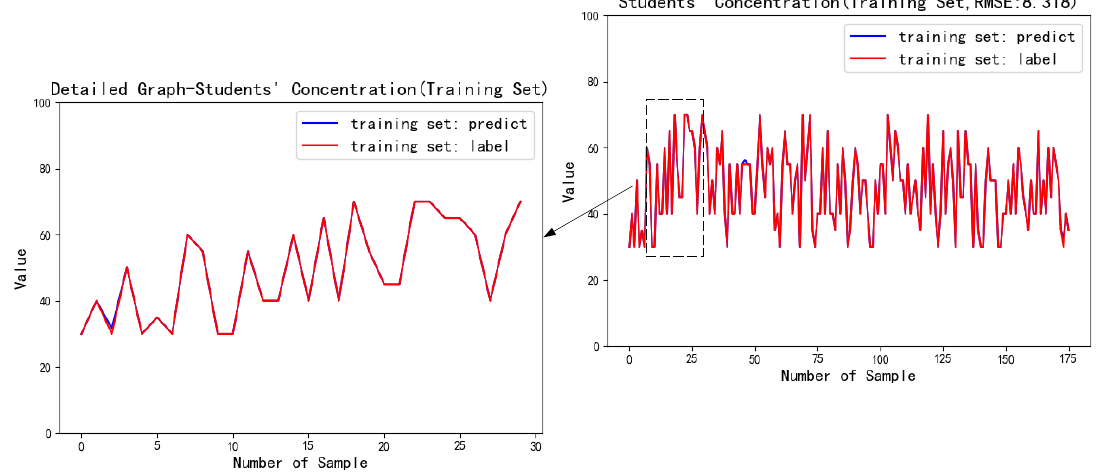
( a ) For students’ concentration in the training set. Figure 11.